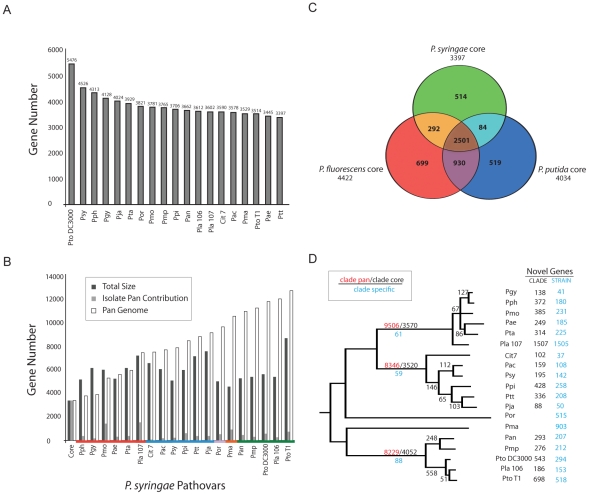
The core- and pan-genome of P. syringae.Collectively, P. syringae isolates share ∼50% of their ORFs with other pseudomonads. (A) The P. syringae core genome contains 3397 genes. (B) The P. syringae pan genome contains 12749 ORFs. (C) P. syringae, P. fluorescens, and P. putida share 2501 ORFs. P. syringae has the smallest core genome (3397) compared to P. fluorescens and P. putida (4422, 4034 respectively). P. fluorescens and P. putida share more genes with each other than either does with P. syringae. (D) Phylogenetic distribution of shared and clade/strain specific genes. Numbers on the earliest branch for each group indicate the size of the core (black) and pan (red) genomes for groups with multiple sequenced genomes (I, II, III), as well as the number of clade specific ORFs (blue, conserved within each group but absent from other groups). Internal branches display the number of ORFs gained, and shared by all genomes, after each branch bifurcation (see Methods). Numbers of ORFs within each genome absent from other strains within the relevant P. syringae group (black) and throughout the species (blue) are shown at the far right. Group I strains (including Pto DC3000) contain the largest number of shared ORFs and the smallest number of pan ORFs. Pja and Pla 107 have the smallest and the largest number of unique ORFs (88, 1507 respectively).